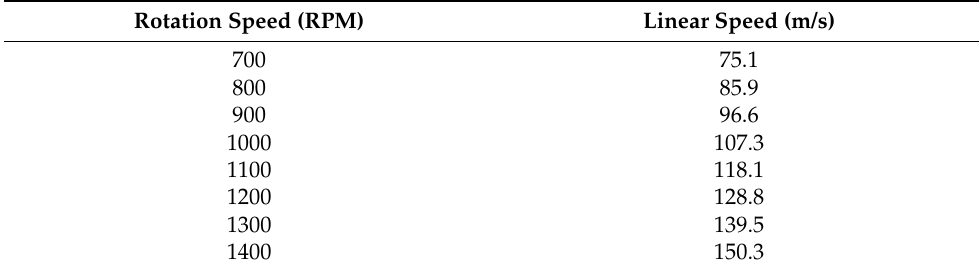
Table 1. Rotational speed to linear speed of ETC rig.